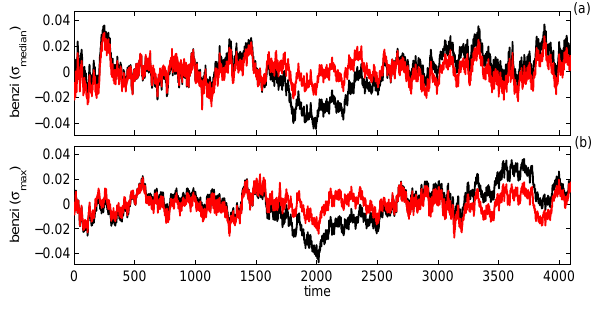
Fig. 13. Two realisations of the Benzi et al. (1993) process are given in black, with their stationary variants in red. From the 50 datasets generated, the data in (a) had the median value for the standard deviation of α(t) and (b) had the